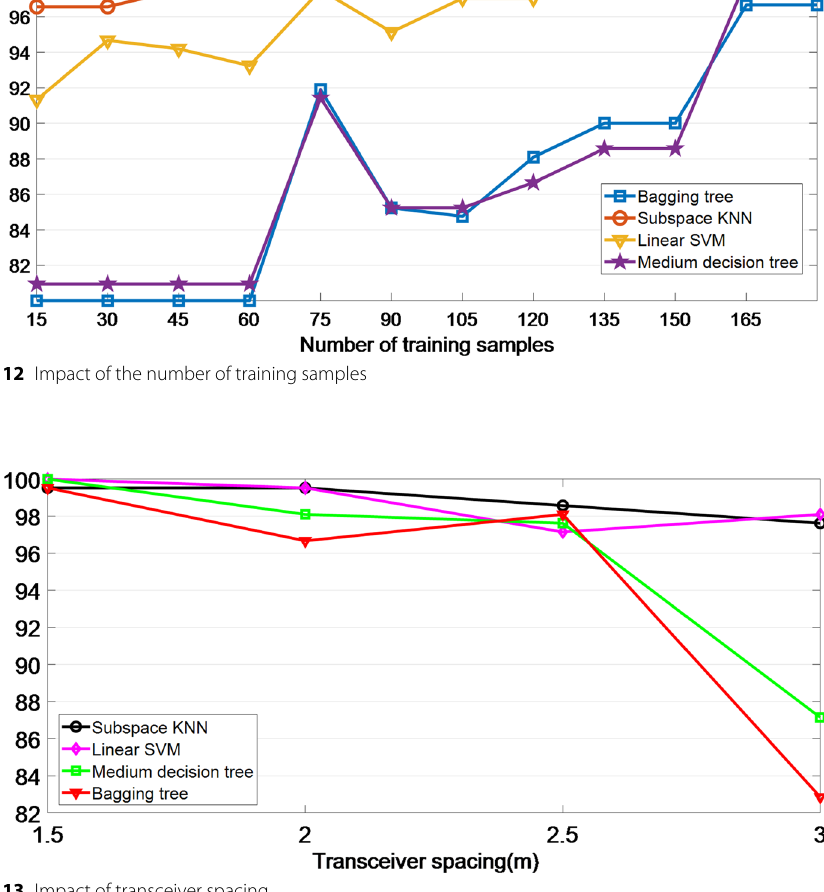
Fig. 13 Impact of transceiver